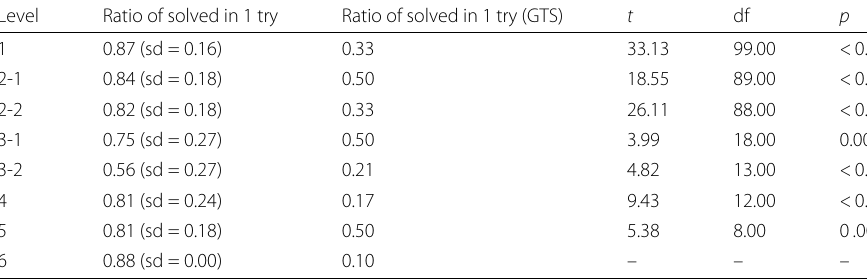
Table 4 One sample t test results comparing measured ratio of problems solved in 1 try to the equivalent “gaming the system” calculated value